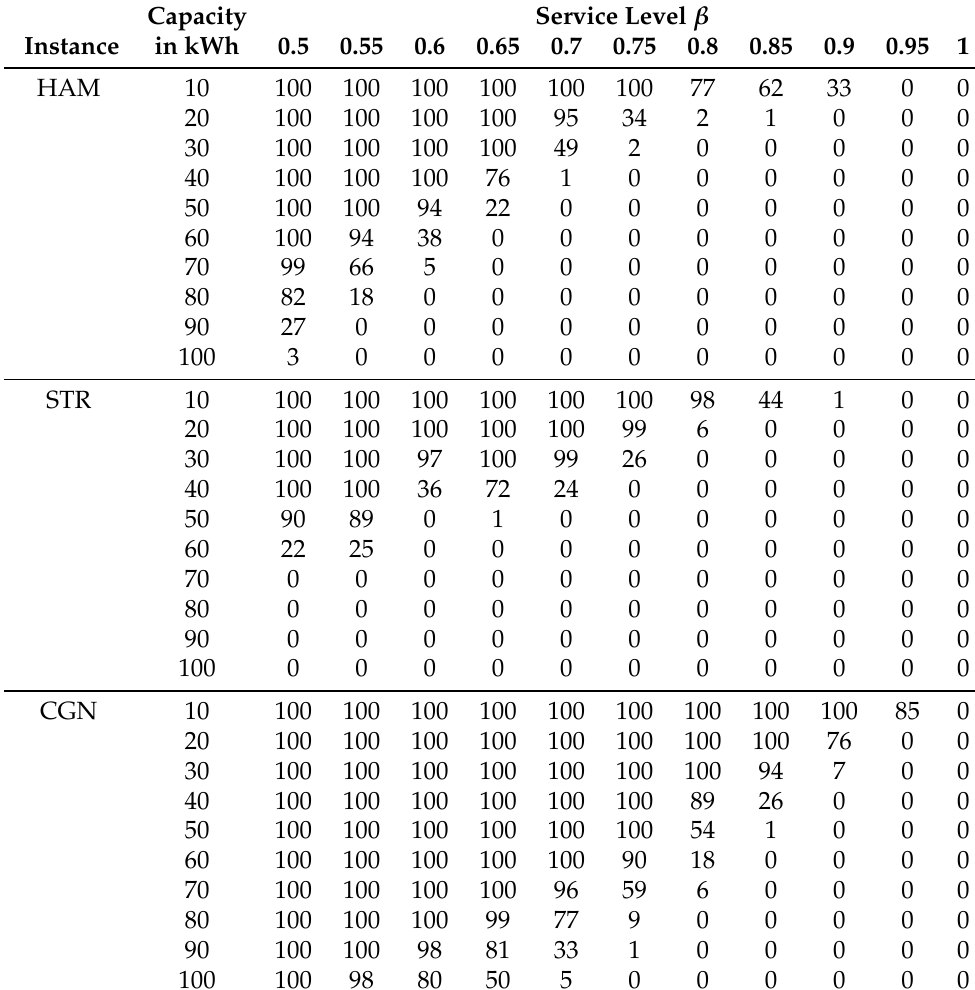
Table 6. Invalid simulation